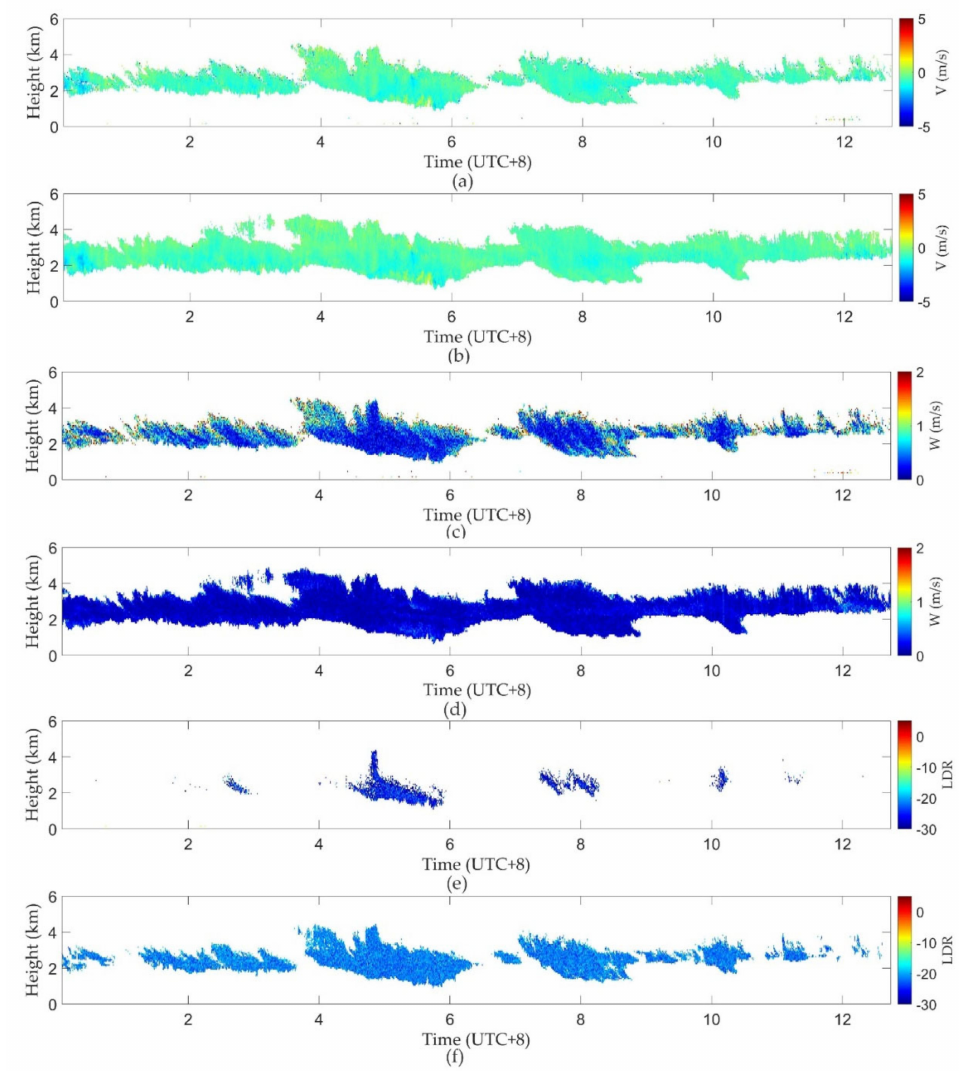
Figure 10. The ( a , b ) V , ( c , d ) W and ( e , f ) LDR measured by the ( a , c , e ) Ka-band radar and ( b , d , e ) W-band radar on 3 March